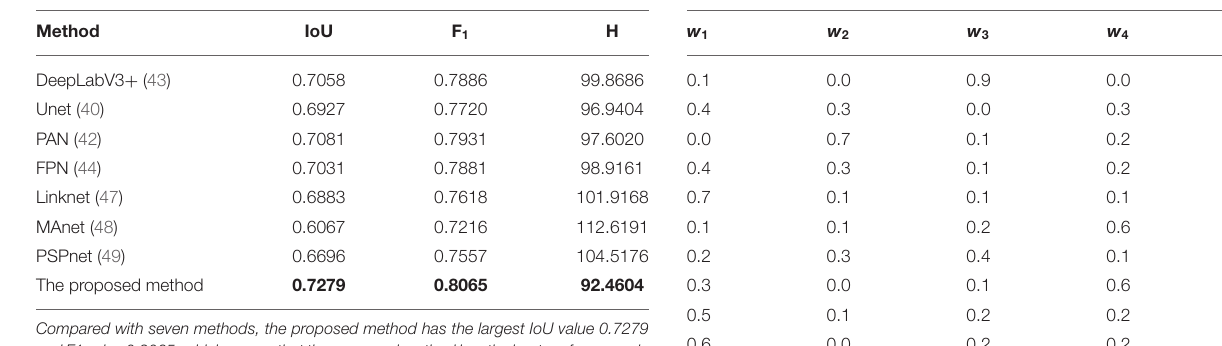
TABLE 4 | The IoU values with different methods. TABLE 5 | The relationship between the weighting parameters and the IoU